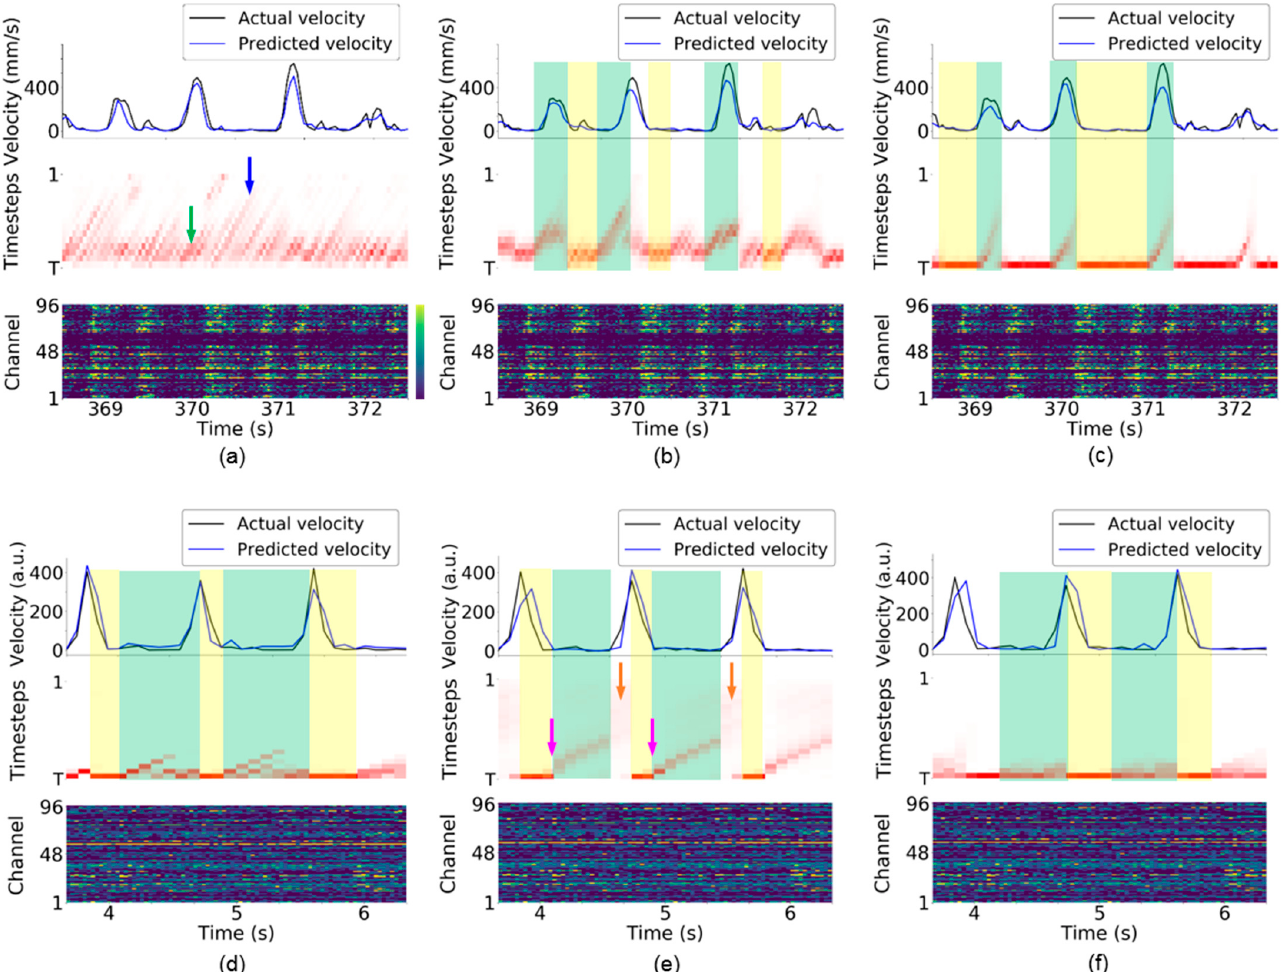
Figure 7. Visualization of attention weights for monkey Indy [23] (top row) and monkey N [24] (bottom row). ( a , d ) Vanilla RNN. ( b , e ) LSTM. ( c , f ) GRU. Each subfigure presents the kinematic state (top), attention weights (middle), and neural activity (bottom). The top panel of each subfigure presents the Euclidean norm of the velocity vector (cid:3427)𝑣 (cid:3051) ,𝑣 (cid:3052) (cid:3431) bottom panel of each subfigure, the firing rate (neural activity) was recorded from a 96-electrode array. For the middle panel of each subfigure, the vertical axis indicates the timesteps used in the RNN-based neural decoder, and the horizontal axis indicates the clock time. The green and blue arrows indicate that the neural decoder highlights shorter and longer timesteps, respectively, in ( a ). The pink arrow indicates the early preparatory period in ( e ). The orange arrow indicates that the attention weights at all timesteps have similar color in ( e ), suggesting that these attention weights have similar values. The green-shaded area indicates that the neural decoder consecutively highlights the neural activity observed in the previous timesteps. The yellow-shaded area indicates that the neural decoder highlights the recently observed neural activity. The examples were obtained from session indy_20161024_03 for monkey Indy and session i140703-001 for monkey N.